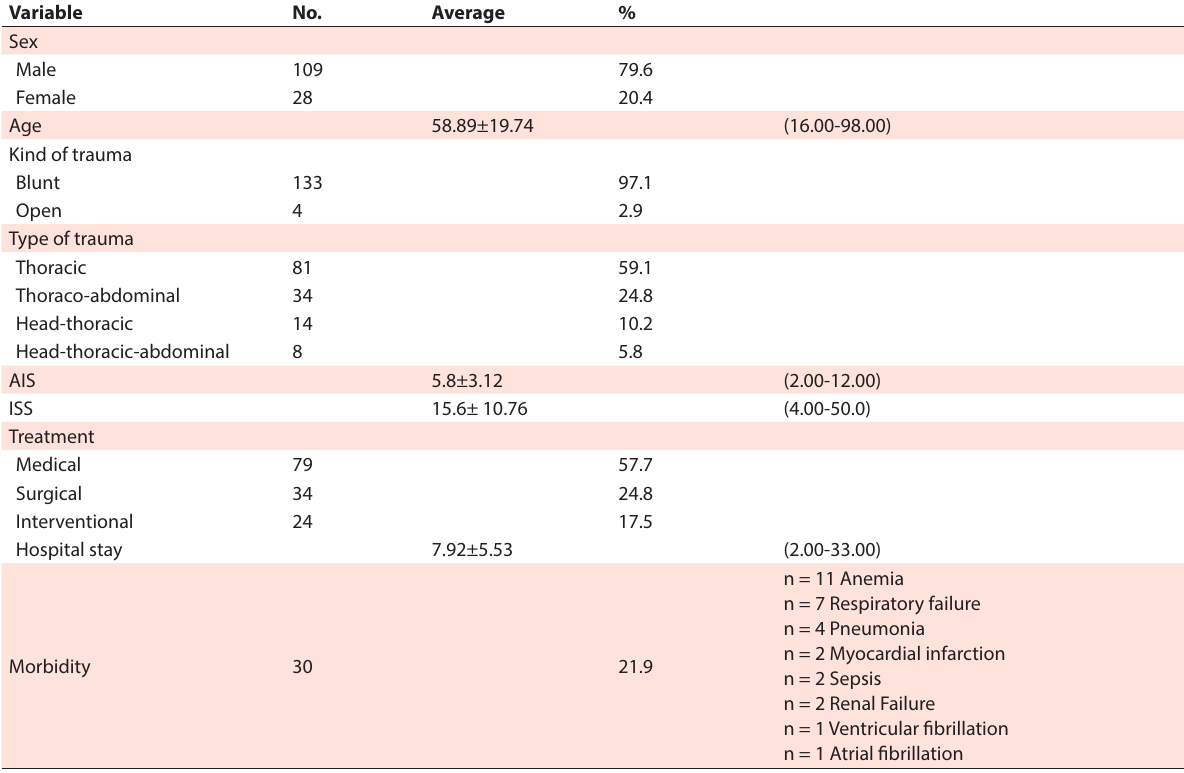
Table 1. General population